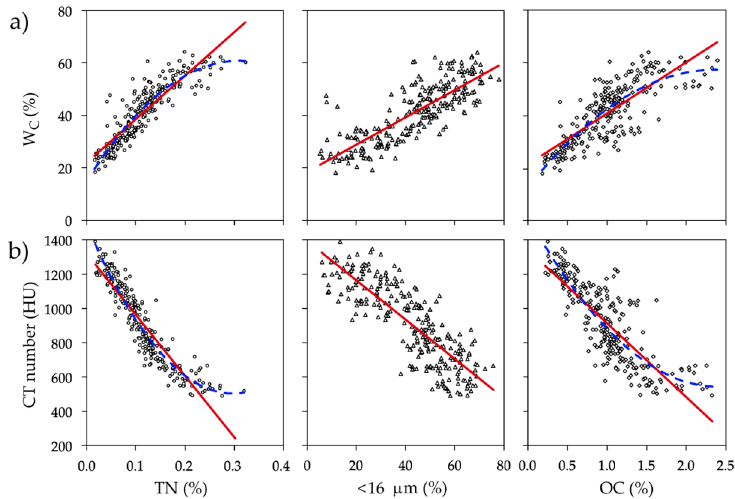
Figure 6. Contents of total nitrogen (TN), <16- µ m grain-size fraction (<16 µ m) and organic carbon (OC) plotted against ( a ) water content and ( b ) CT number. Linear regression (solid lines), and for TN and OC, second-degree polynomial fit (broken line) correspond to regression coefficients shown in Table 3.